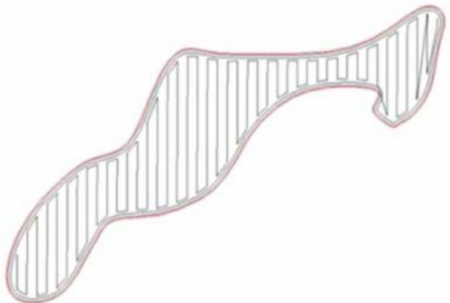
Figure 3. Example of a generated contour reproduced with permission from [18]. Elsevier, 2011. Shape accuracy: Routhu et al. [23] improved the zigzag and o ff set pattern based on the